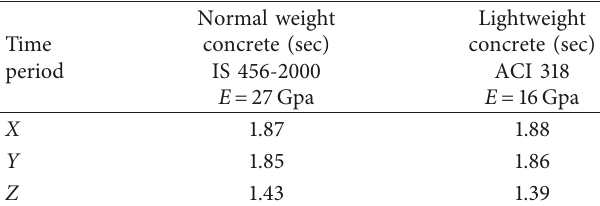
Table 5: Time periods.